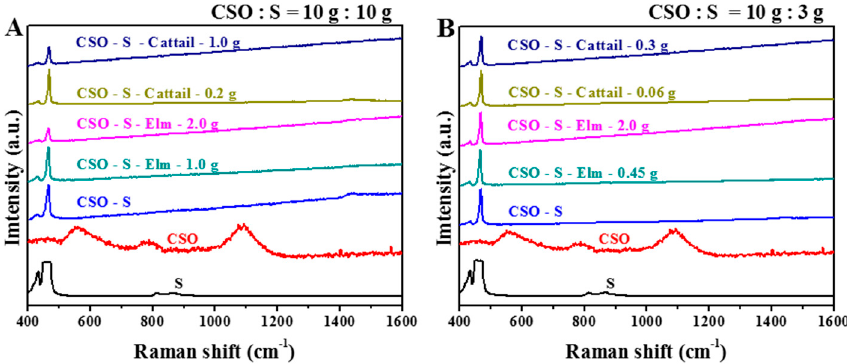
Figure 9. Raman spectra of sulfur, CSO, and bio-based polysulfide composites. ( A ) 10.0 g CSO + 10.0 g S + different fillers, ( B ) 10.0 g CSO + 3.0 g S + different fillers.